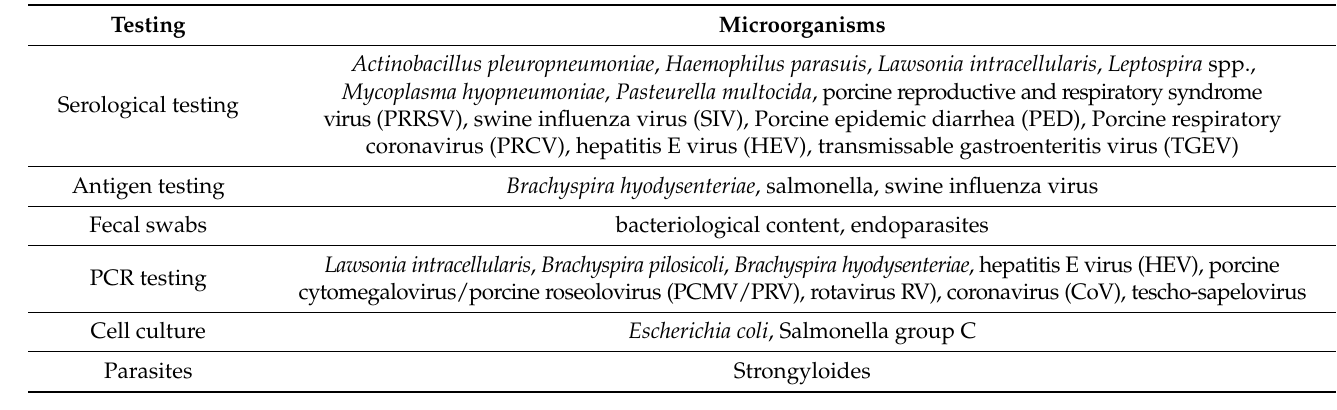
Table 3. Microorganisms tested in the pig facility of the CiMM in Munich, Germany [53].